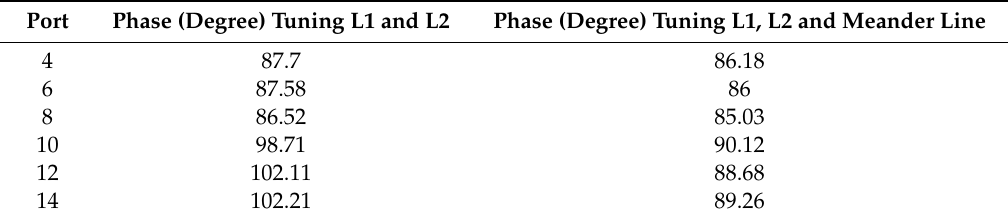
Figure 9. (a) Top view of the non-uniformly powered and spaced 12-element patch array. ( b ) Simulated normalized gain of the non-uniformly powered and spaced 12-element patch array with co- and cross-polarization. (c) Simulated S 11 of the same antenna array.